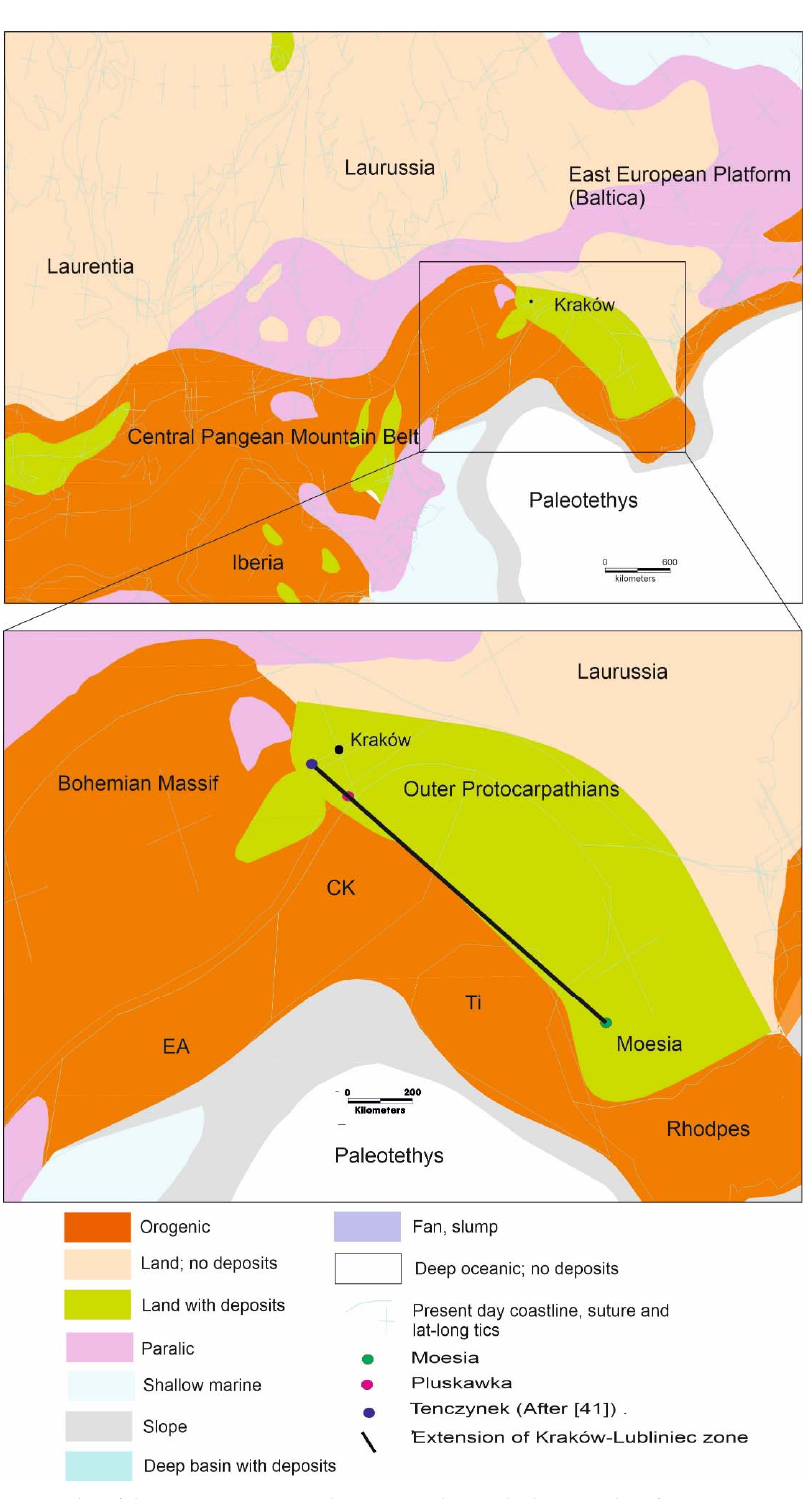
Figure 7. Paleogeography of the circum-Protocarpathian region during the latest Carboniferous–Permian. Abbreviations: CK = Central Carpathians; EA = Eastern Alps; Ti = Tisza.